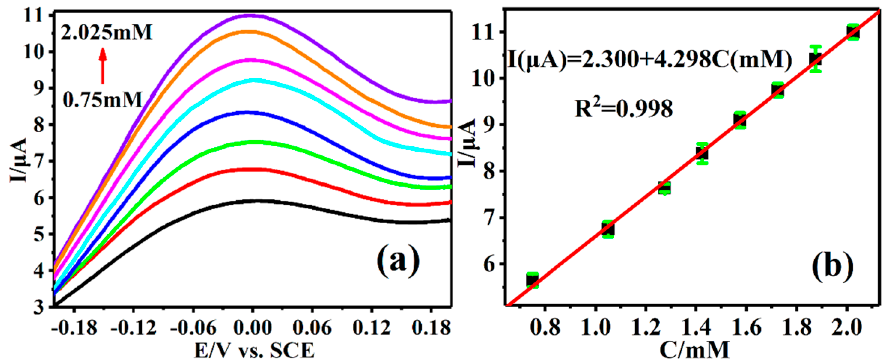
Figure 6. ( a ) DPVs of Cu-TCPP@MOFs/GCE in different concentrations of AA solution. ( b ) The standard curves of the peak currents versus different concentrations of AA solution.